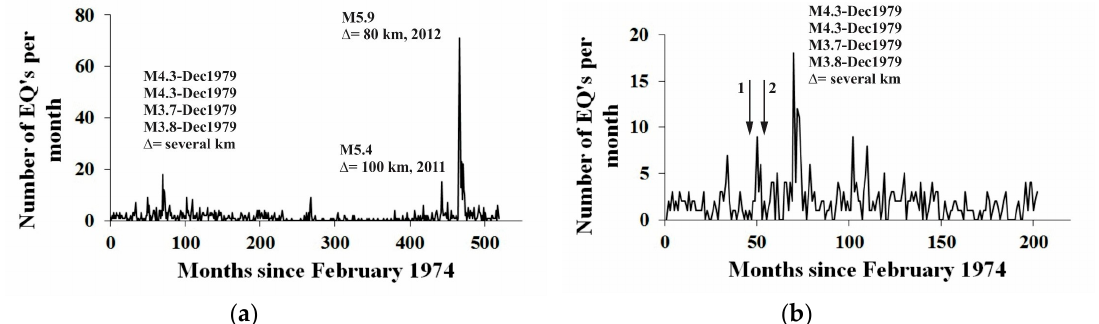
Figure 4. Number of EQs (M ≥ 2.2) per month versus month number in the radius 100 km from the dam, ∆ is the distance from the epicenter of a given EQ to the dam: ( a ) From February 1976 till 2017; ( b ) from February 1976 till 1991. Arrow marks 1 and 2 in Figure 5b correspond to 1) the beginning of filling, and 2) the WL rising to 100 m